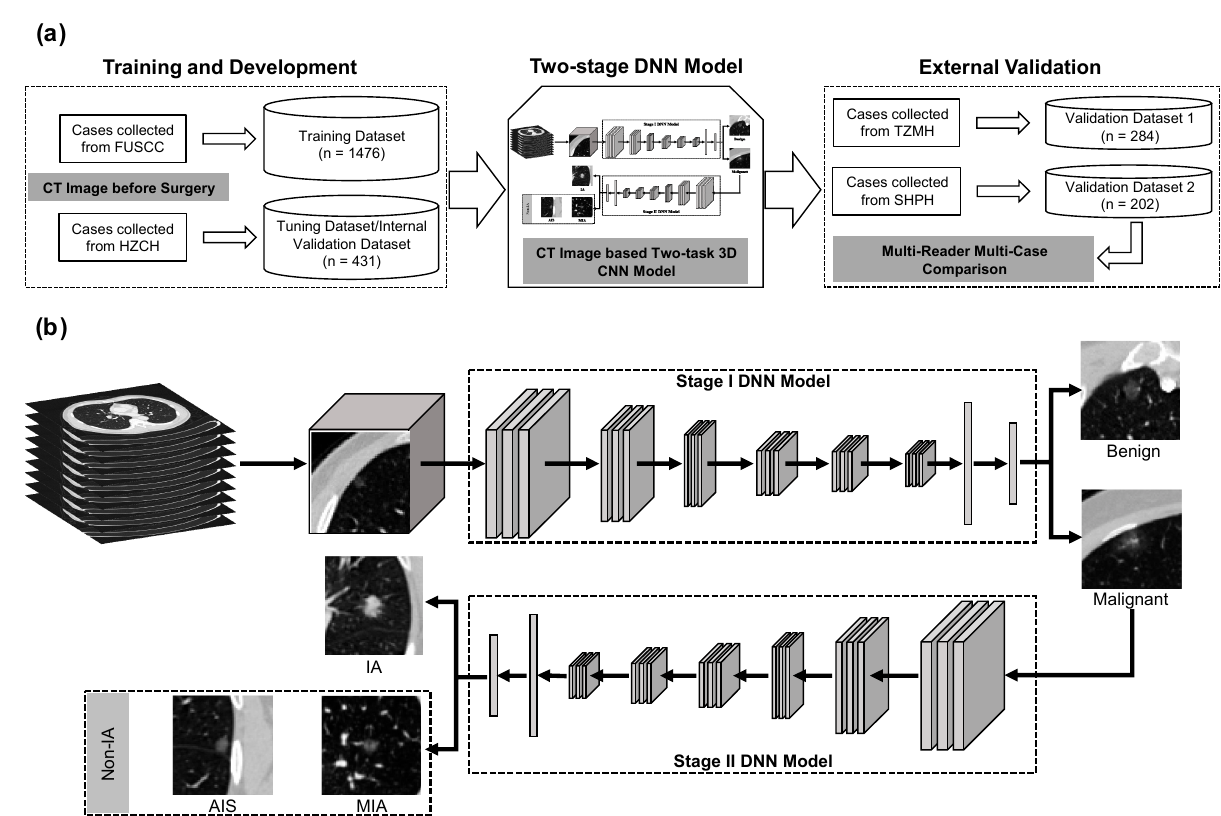
Figure 1. The workflow of model development. ( a ) Schematic workflow of the study for training and external validation of a CT image-based DNN model. ( b ) Flowchart of the proposed two-stage DNN model. The stage I DNN model was used to classify benign and malignant GGNs. The stage II DNN model was used to predict the invasiveness risk of malignant tumors. FUSCC = Fudan University Shanghai Cancer Center. HZCH = Huzhou Central Hospital. TZMH = Taizhou Municipal Hospital. SHPH = Shanghai Pulmonary Hospital.